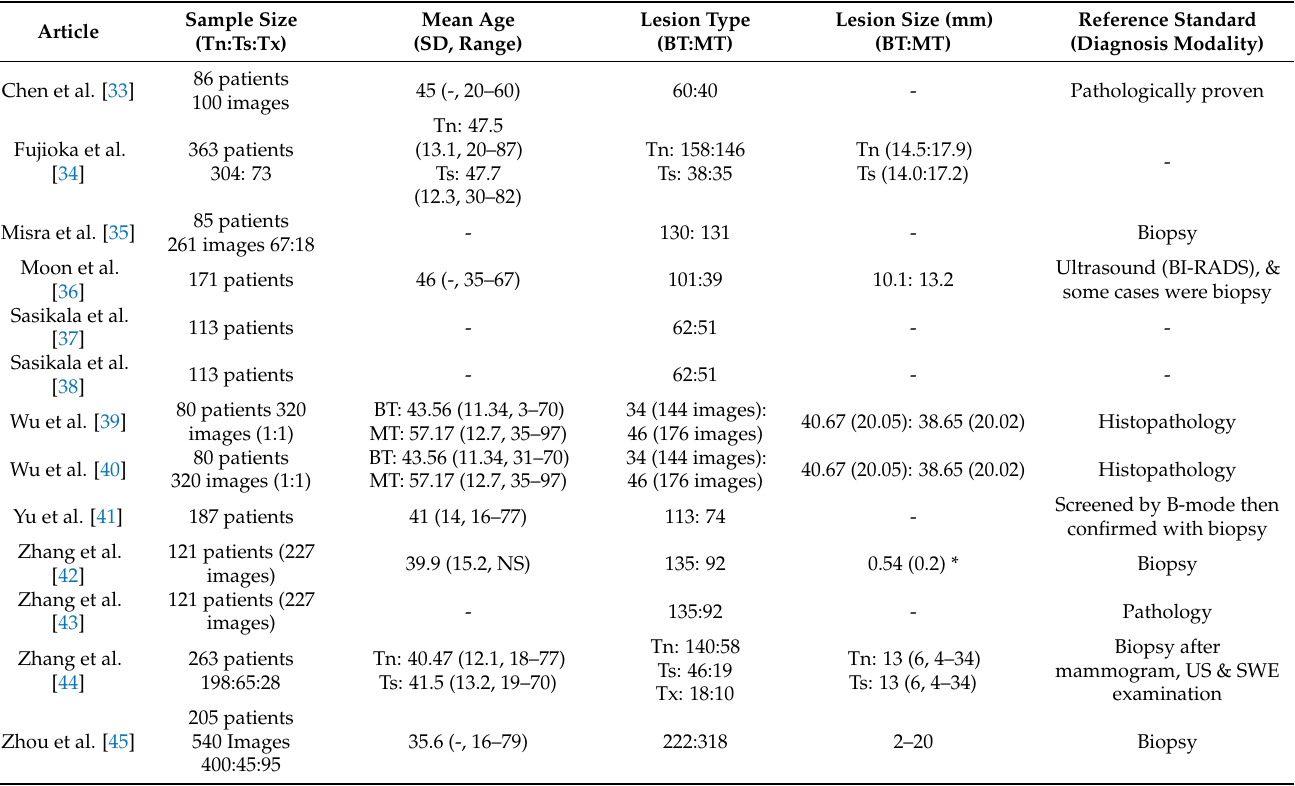
Table 1. Subject information and